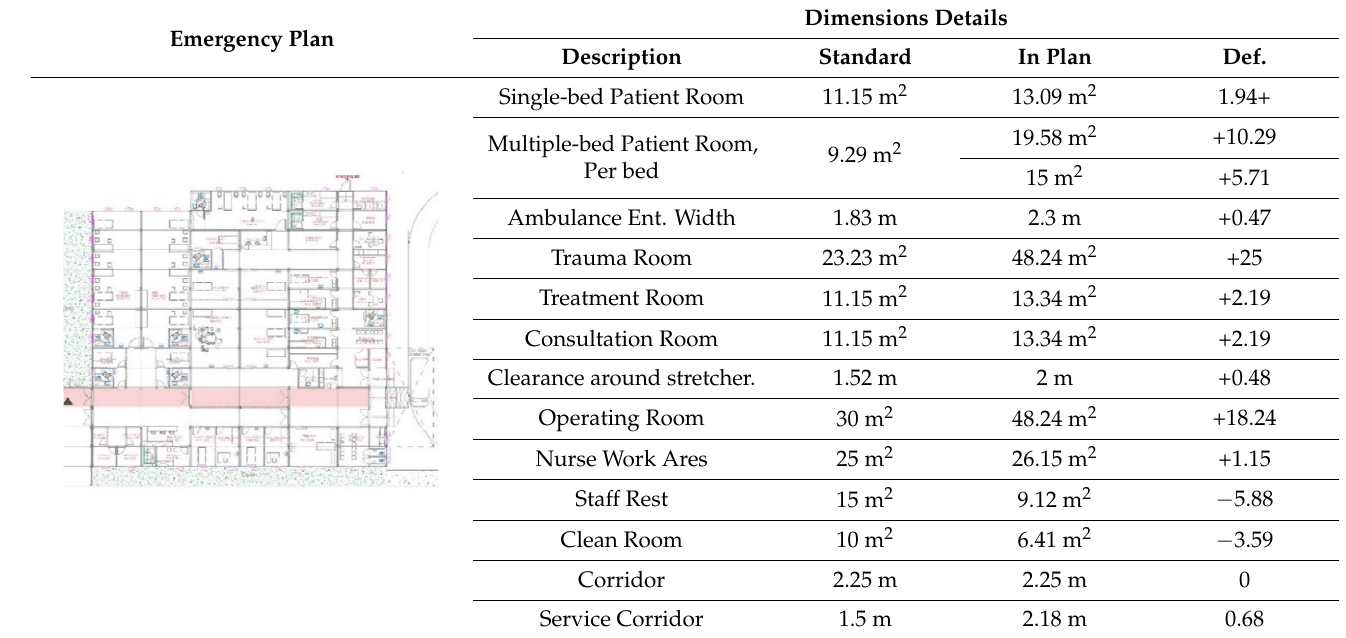
Table 2. Dimensional requirements of the emergency department compared to standards.